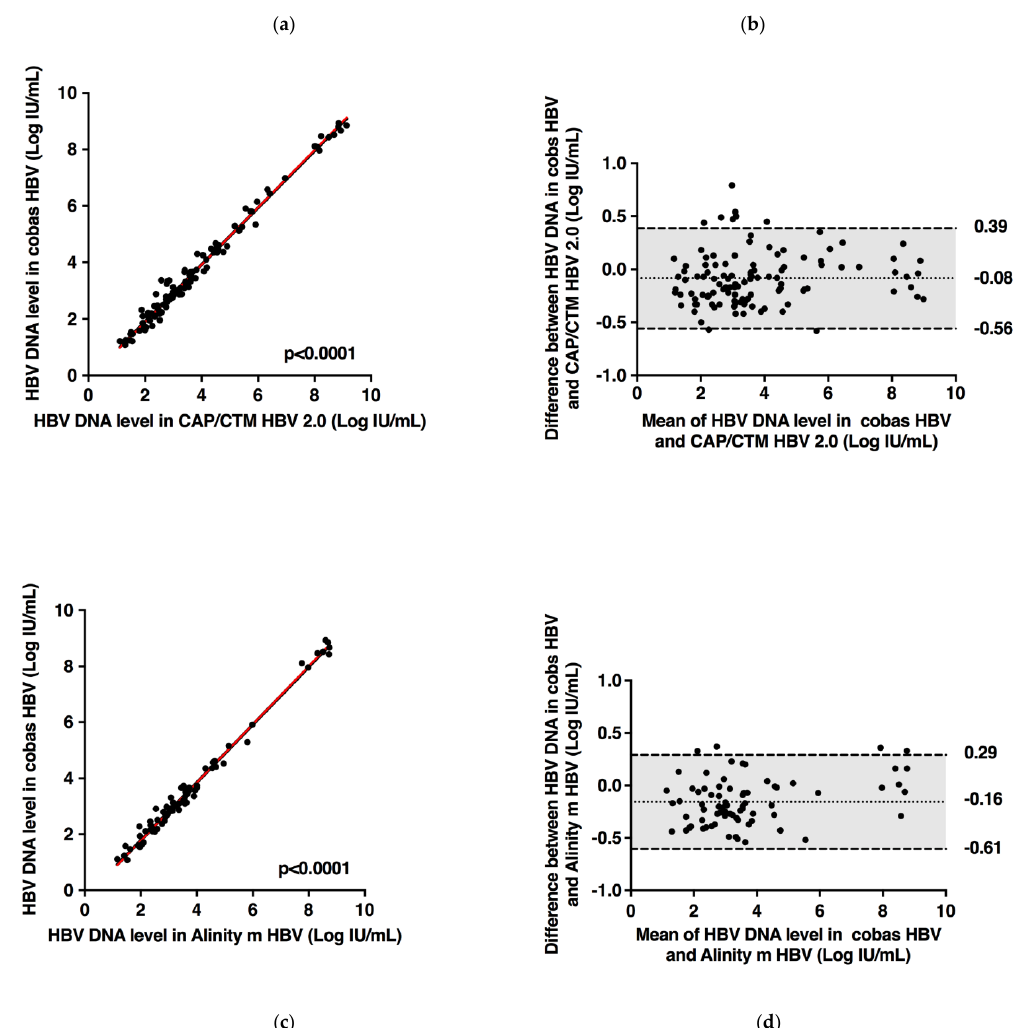
Figure 2. Deming linear regression ( a ) and Bland–Altman plot analysis ( b ) of HBV DNA measured by cobas ® HBV Test and CAP/CTM HBV Test v2.0 in 121 plasma specimens containing different HBV genotypes. Deming linear regression ( c ) and Bland–Altman plot analysis ( d ) of HBV DNA measured by cobas ® HBV Test and Alinity™ m HBV assay in 83 plasma specimens containing different HBV genotypes. In the Bland-Altman graphs, the dotted and dashed lines represent the mean difference and the ± 1.96 SD, respectively.